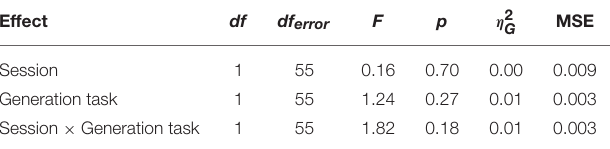
FIGURE 8 | Mean proportion of pattern type trials for each session type on both generation tasks. Error bars indicate 95%